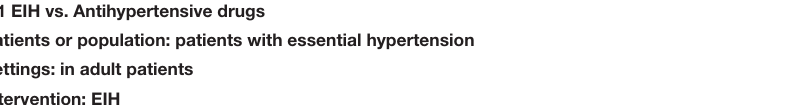
TABLE 4 | Summary of findings table: the three most important patients outcomes are listed in the summary of findings